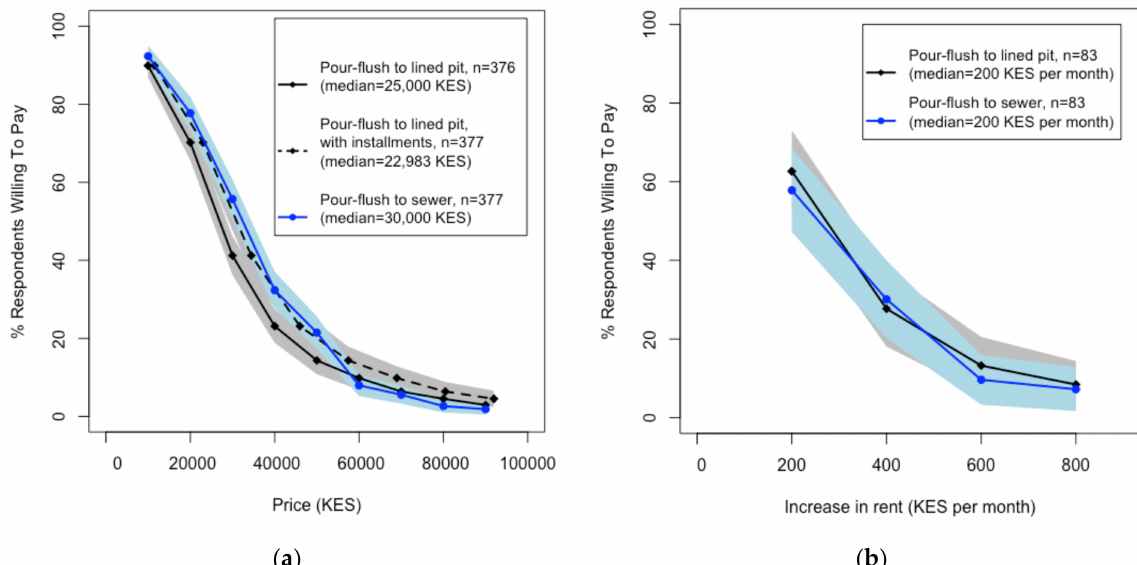
Figure 2. Demand curves for high-quality, pour-flush latrine options derived from survey-based stated WTP information. ( a ) Stated WTP levels among landowners and homeowners at different price points for the two high-quality latrine options. ( b ) Stated WTP levels for rent increases among tenants to support the provision of high-quality latrine options. Both groups provided WTP for pour-flush latrines connected to lined pits (black) and pour-flush latrines connected to the sewer (blue); the shaded areas represent 95% confidence intervals. In ( a ), the solid lines represent the stated WPT in the scenario of one-time payments; the dashed line represents the stated WTP in the scenario of 12 monthly